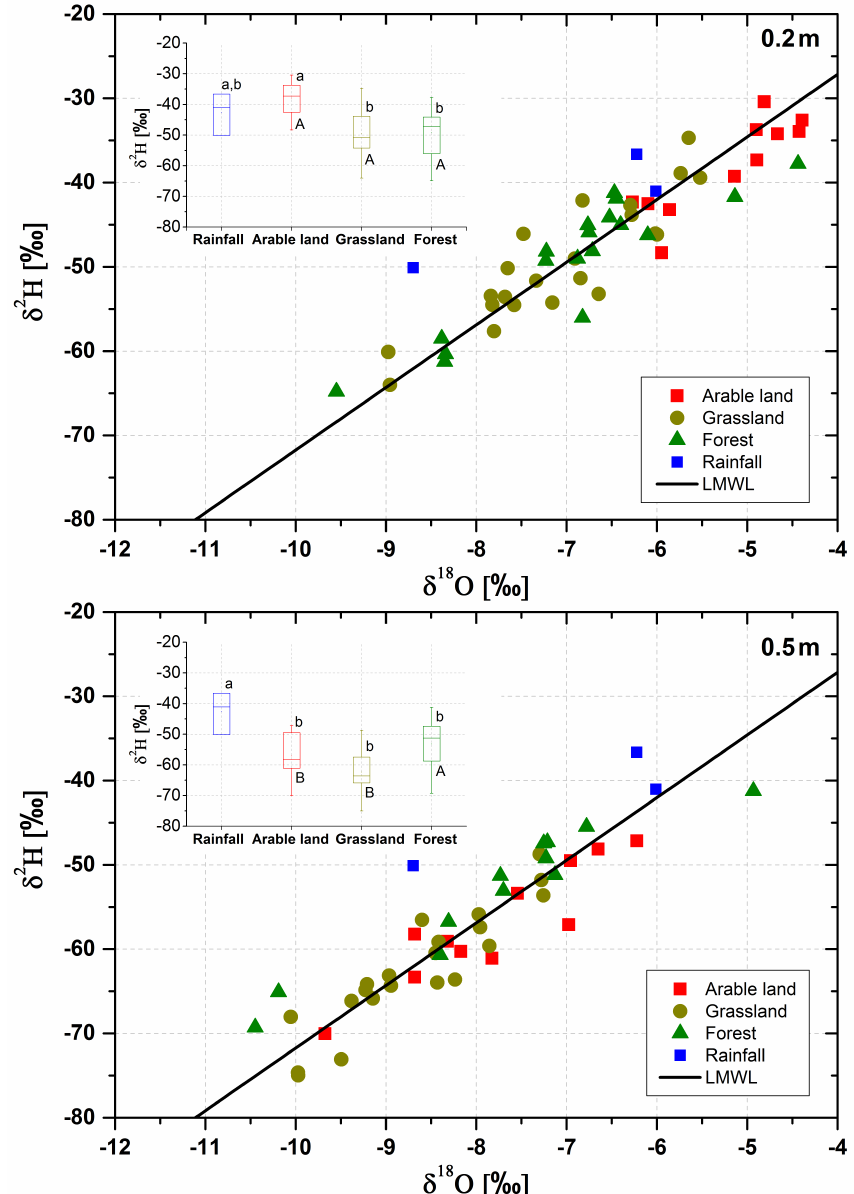
Figure 5. Dual isotope plot of soil water isotopic signatures at 0.2 and 0.5m depth compared by land use including precipitation isotope data from 19, 21, and 28 October 2011. Insets: box plots comparing δ 2 H isotopic signatures between different land use units and precipitation (small letters) in top- and subsoil (capital letters). Different letters indicate significant differences ( p ≤